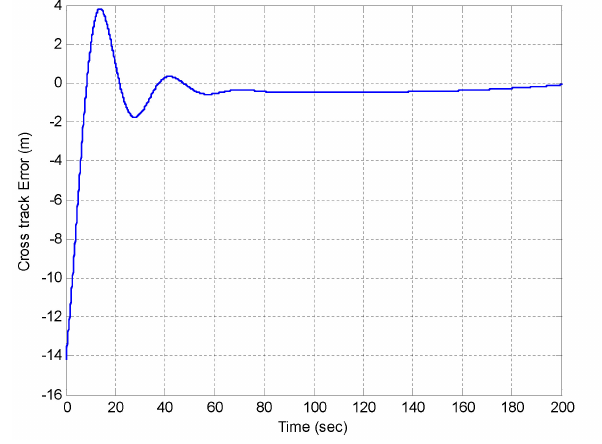
Figure 24. Evolution of cross-track error during arc